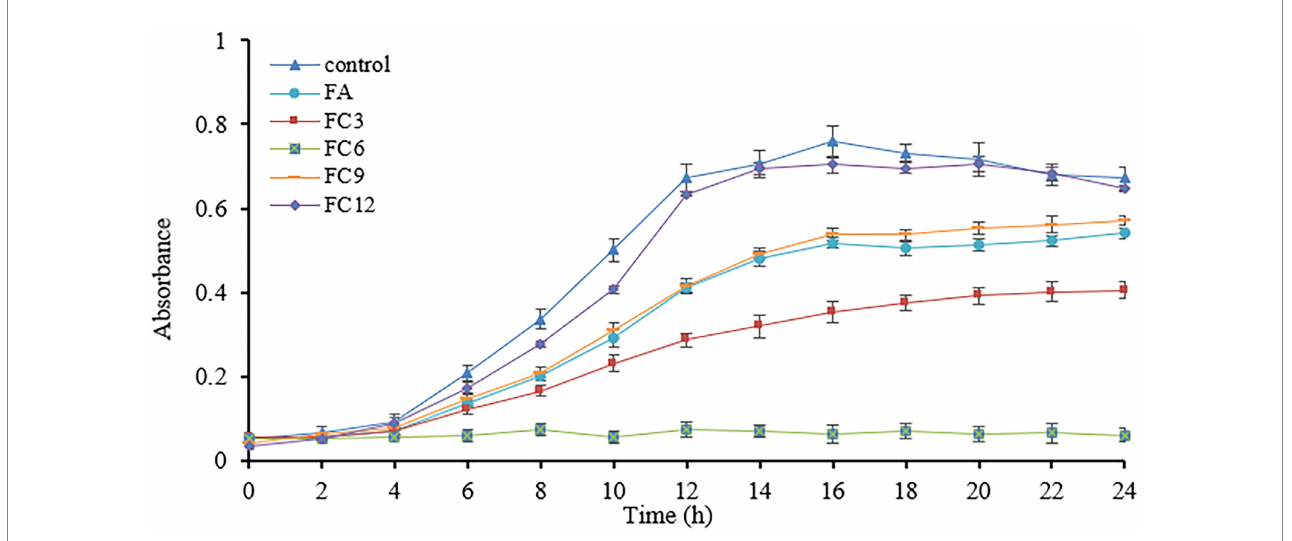
FIGURE 2 Effect on the growth curve of Pseudomonas